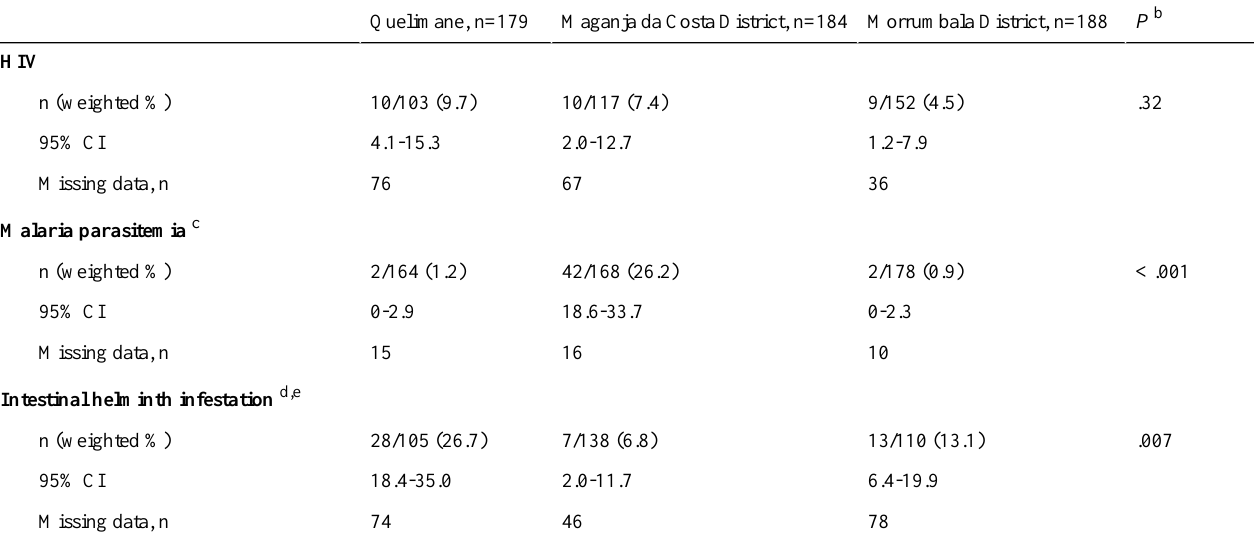
Table 3. Numbers of positive cases and prevalence estimates (weighted percentages) for HIV, malaria parasitemia, and intestinal helminth infestation in the study regions a